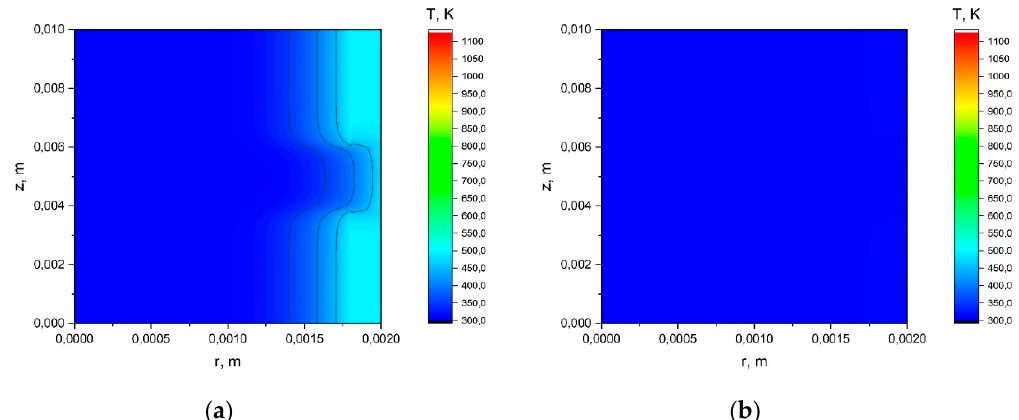
Figure A16. Temperature distribution in the stem of a herbaceous plant: R = 0.002 m, t = 0.5 s, q = 30 kW/m 2 ( a ); R = 0.002 m, t = 3 s, q = 0.5 kW/m 2 ( b ).